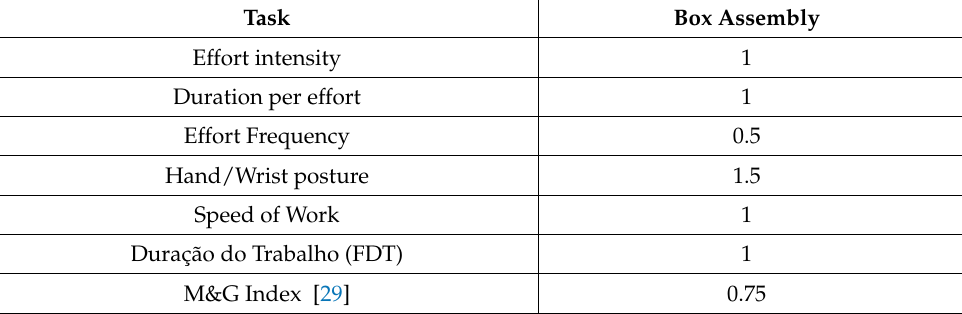
Table 9. Moore and Garg analysis after automation process.